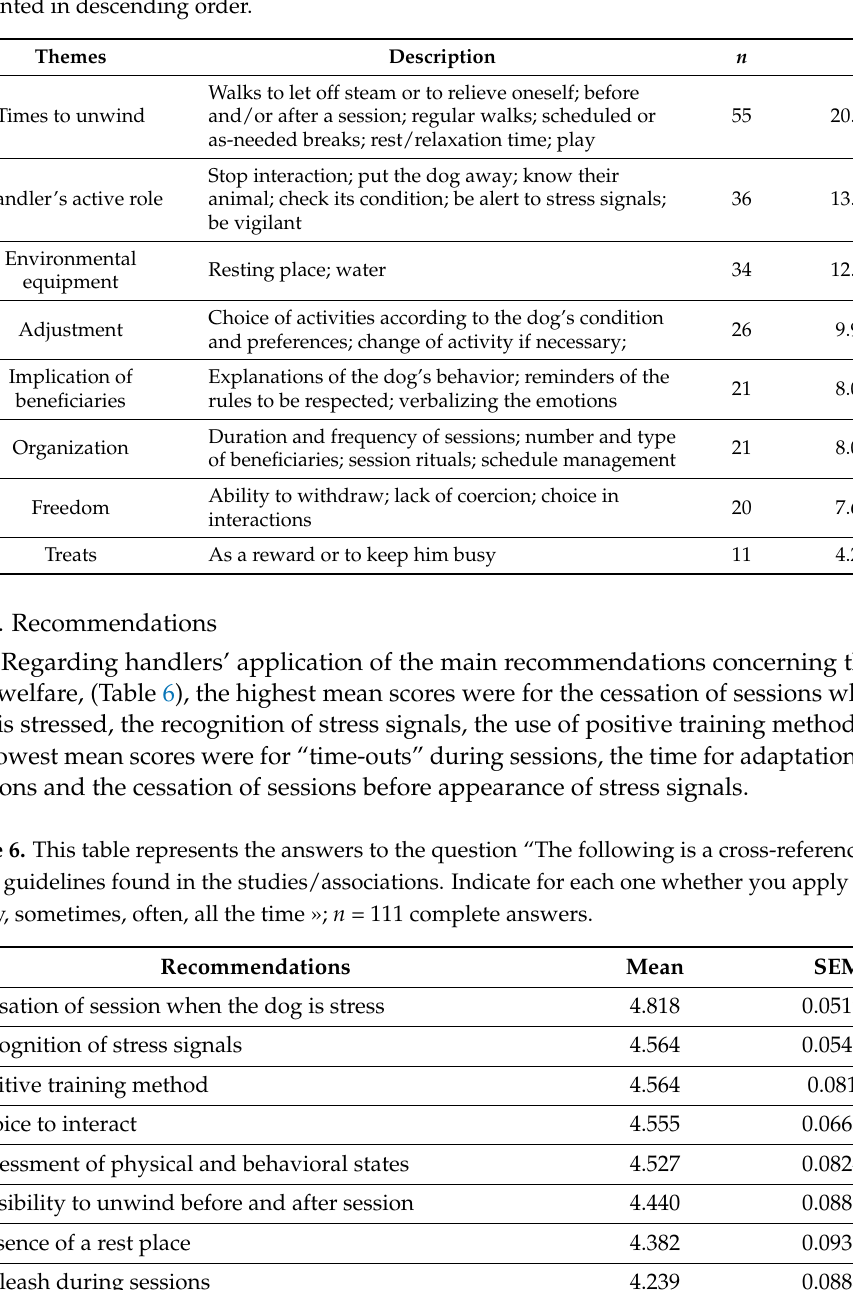
Table 5. This table represents the answers to the question “What do you put in place to respect your dog’s well-being?”. n = 109 complete answers. Total of 262 terms coded grouped into 8 themes; presented in descending order.